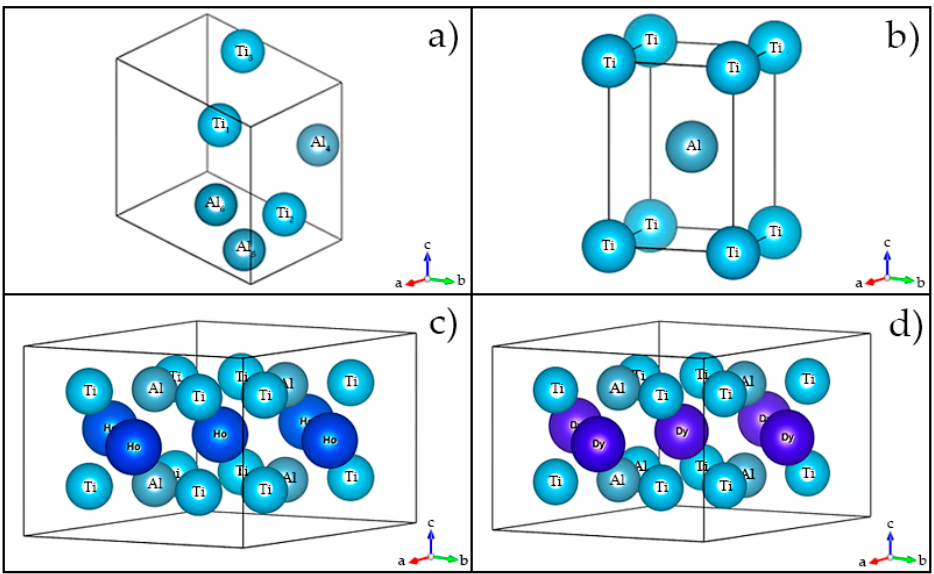
Figure 2. The 3D reference lattices of the Al-Ti alloys with addition of REM: Ho ( a ) Al 3 Ti 3 , ( b ) Al-Ti, ( c ) Al 4 Ti 12 Ho 3 , and ( d ) Al 4 Ti 12 Dy 3 . The obtained results indicate that the synthesized Ti 49 Al 49 Ho 2 and Ti 49 Al 49 Dy 2 com- pounds are dominated by binary AlTi-based compounds, whose proportion exceeds